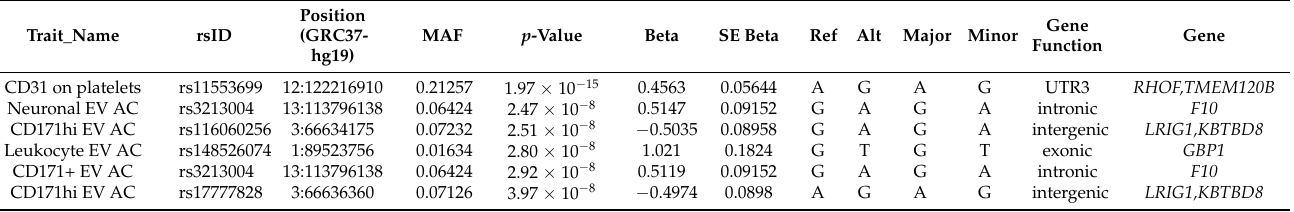
Table 1. GWAS results for EVs and platelets. p -values lower than 5.00 × 10 − 8 were shown. Beta + referred to the alternative (Alt) allele. Minor allele frequency (MAF); Standard error of beta (SE beta); Reference allele